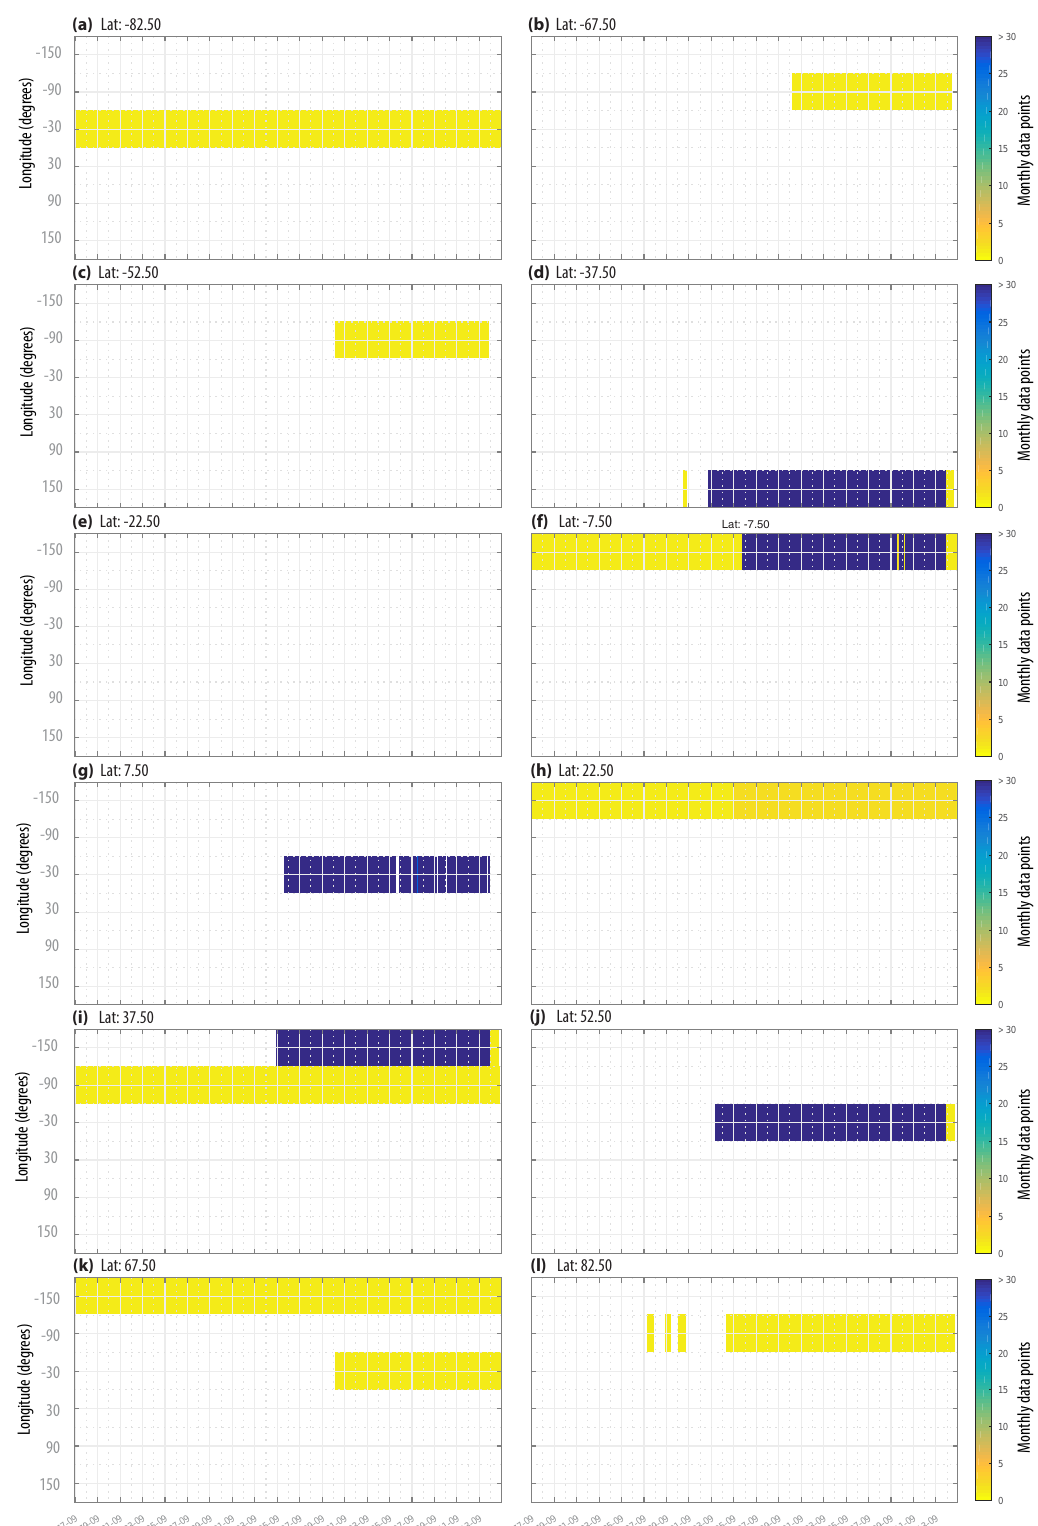
Figure 4. Availability of instrumental N 2 O data from 1983 to 2015 from the AGAGE and NOAA ESRL networks, shown as data samples per month, per latitudinal band (a–l) and per longitudinal bin within each latitudinal